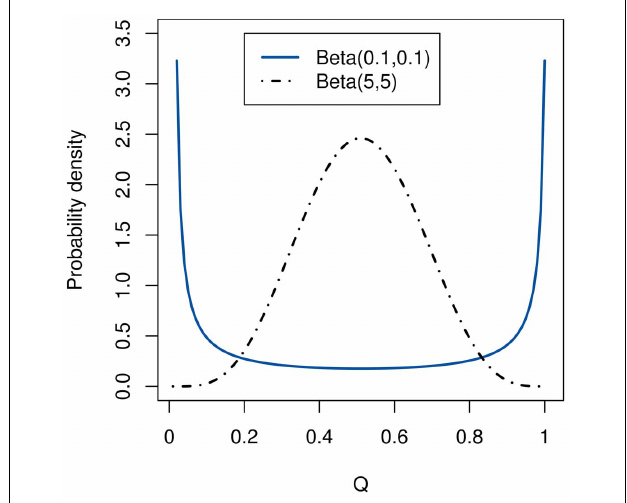
FIGURE 2 | Unlike a Gaussian, a Beta distribution can represent both double-peaked (with α , β < 1) and single-peaked (with α , β > 1) distributions.